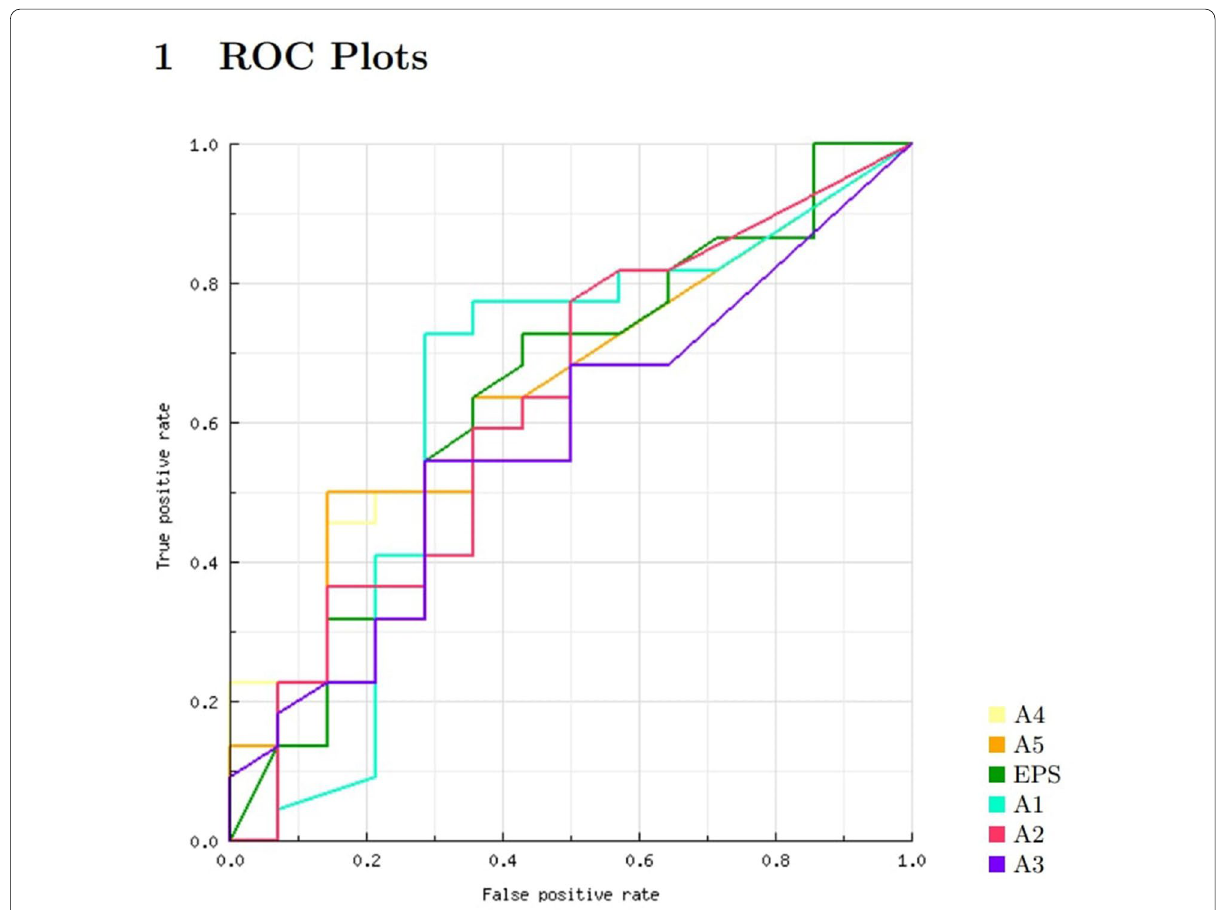
Fig. 5 Receiver operating characteristic (ROC) curve analysis regarding the predictive value of 3D electroanatomical origin (EPS) and the five ECG algorithms for differentiating (A1–A5) when assessment was performed by the